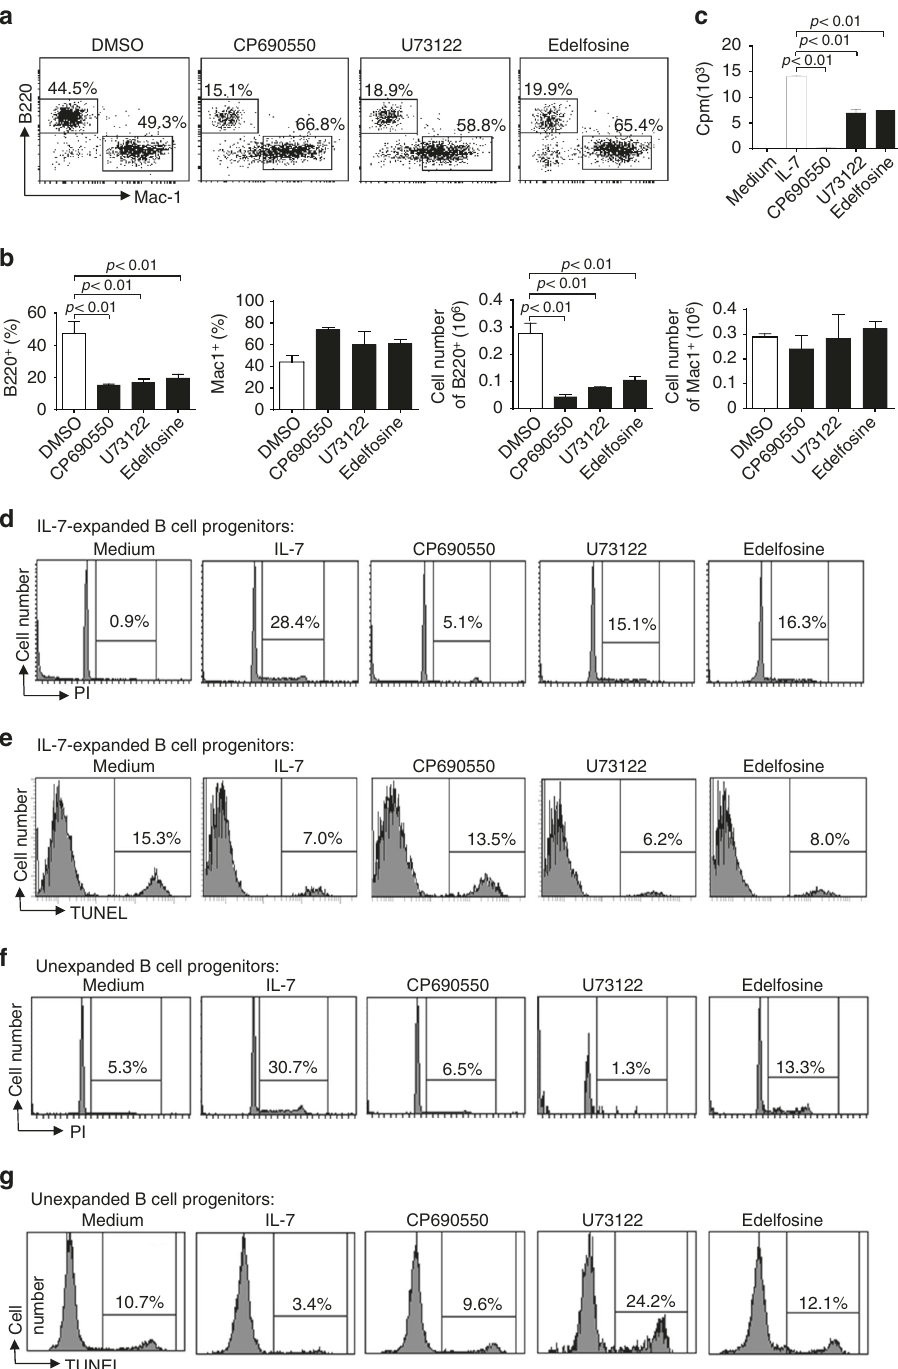
Fig. 3 Effect of inhibition of the PLC γ pathway on IL-7-dependent B cell functions. a , b PLC γ pathway inhibition impairs IL-7-dependent B cell production. Lin − BM cells from wild-type mice were cultured on OP9 cells in the presence of IL-7 for 1 day and then the cells were treated with DMSO, CP690550, U73122, or edelfosine. The cells were stained with anti-B220 and anti-Mac-1. Numbers indicate percentages of B220 + and Mac-1 + cells in the gated live cells ( a ) and bar graphs show the percentages and numbers of B220 + and Mac-1 + cells ( b ). c – e PLC γ pathway inhibition impairs IL-7-mediated proliferation but not survival of in vitro-expanded B cell progenitors. BM cells from Rag1 -de fi cient mice were cultured in the presence of IL-7 for 7 days to derive B cell progenitors. These B cell progenitors were then cultured without IL-7 (medium) or with IL-7 plus DMSO, CP690550, U73122, or edelfosine. Cell proliferative responses were determined by [ 3 H] thymidine incorporation ( c ), cell-cycle analysis was performed by PI staining ( d ), and cell survival was measured by TUNEL staining ( e ). f , g PLC γ pathway inhibition impairs IL-7-mediated proliferation and survival of unexpanded B cell progenitors. B220 + IgM − IL-7R + B cell progenitors were sorted from wild-type mice and cultured without IL-7 (medium) or with IL-7 plus DMSO, CP690550, U73122, or edelfosine. Cell-cycle analysis was performed by PI staining ( f ) and cell survival was measured by TUNEL staining ( g ). Error bars show ± SEM. Data shown are obtained from or representative of 3 ( a , b ), 6 ( c ), 7 ( d , e ), and 5 ( f , g ) independent